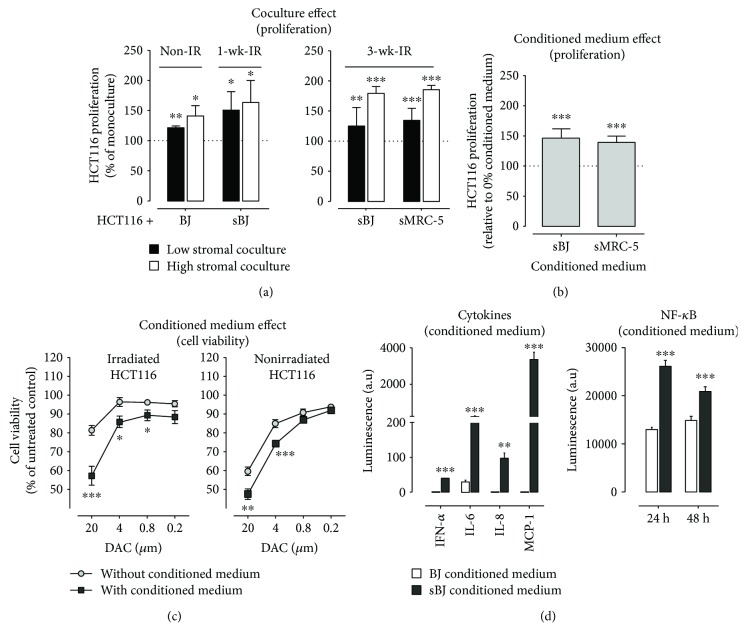
Coculture effect on HCT116 proliferation and analysis of secretory factors in conditioned medium. (a, b) The effect of normal and senescent fibroblasts (a) and SASP of senescent fibroblasts (b) on the proliferation of HCT116. Data are mean ± SEM, n = 2–4, ∗∗∗
p < 0.001, ∗∗
p < 0.01, ∗
p < 0.05 compared to HCT116 monocultures or 0% conditioned medium, one-sample t-test. (c) Viability of nonirradiated and irradiated HCT116 following DAC treatment. Data are mean ± SEM, n = 4, ∗∗∗
p < 0.001, ∗∗
p < 0.01 comparing cell viability with or without conditioned medium, Student's t-test, unpaired. (d) Increased levels of IFN-α, IL-6, IL-8, and MCP-1 in sBJ conditioned medium compared to conditioned medium from normal BJ cells and its effect on NF-κB activity. Data are mean ± SEM, n = 3, ∗∗∗
p < 0.001, ∗∗
p < 0.01 comparing conditioned medium from BJ to sBJ, Student's t-test, unpaired.